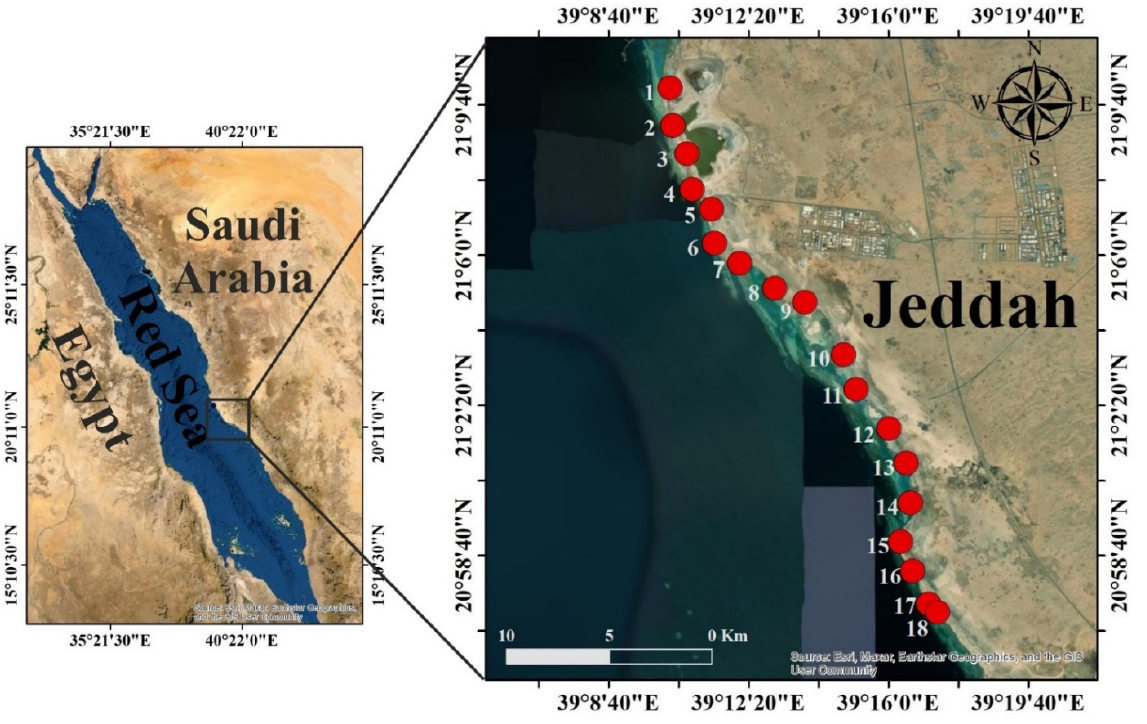
Figure 1. The study area and sampling site’s locations.